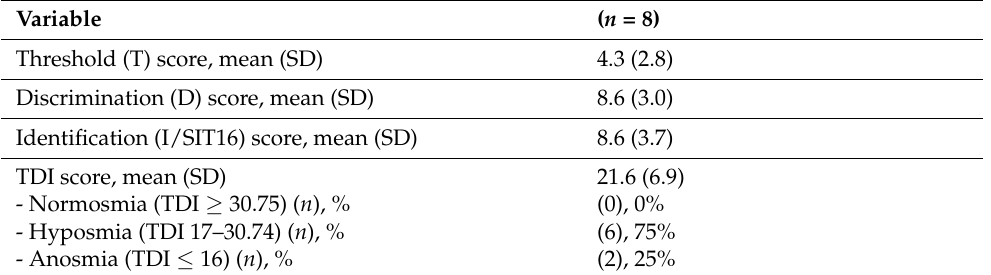
Table 3. Psychophysical olfactory test (Threshold, Discrimination, and Identification) results 12 months after hospitalisation for COVID-19 in patients with hyposmia/anosmia. Variable ( n = 8) Threshold (T) score, mean (SD) 4.3 (2.8) Discrimination (D) score, mean (SD) 8.6